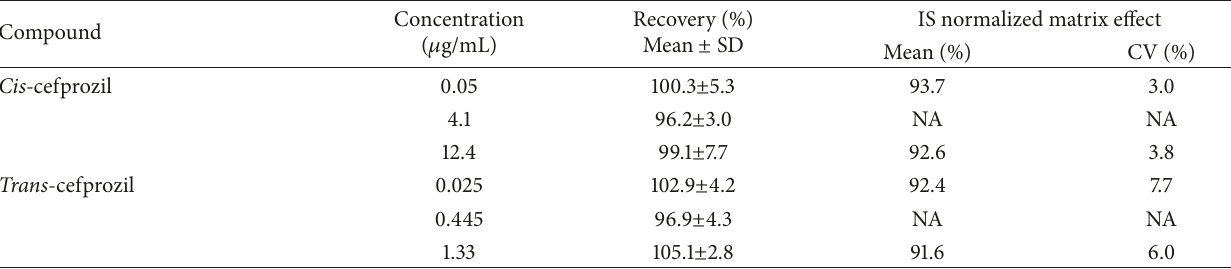
Table 2: Assessment of recovery and matrix effect for cis - and trans -cefprozil ( n = 6). Compound